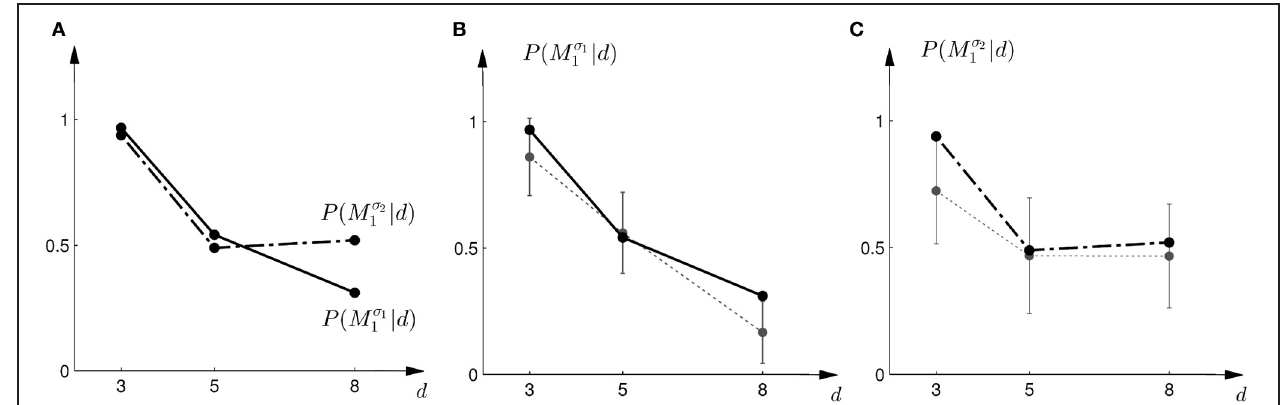
study (solid line) and the experimental results for three different widths d of the ambiguous feedback array. The dotted line shows the mean and standard deviation across subjects of the experimentally observed probabilities of choosing M σ 1 1 . (C) Shows the predictions (dash-dot line) as well as the experimentally observed choice probabilities (dotted line represents mean with standard deviation error bars across subjects) for choosing M σ 2 1 in the second part of the